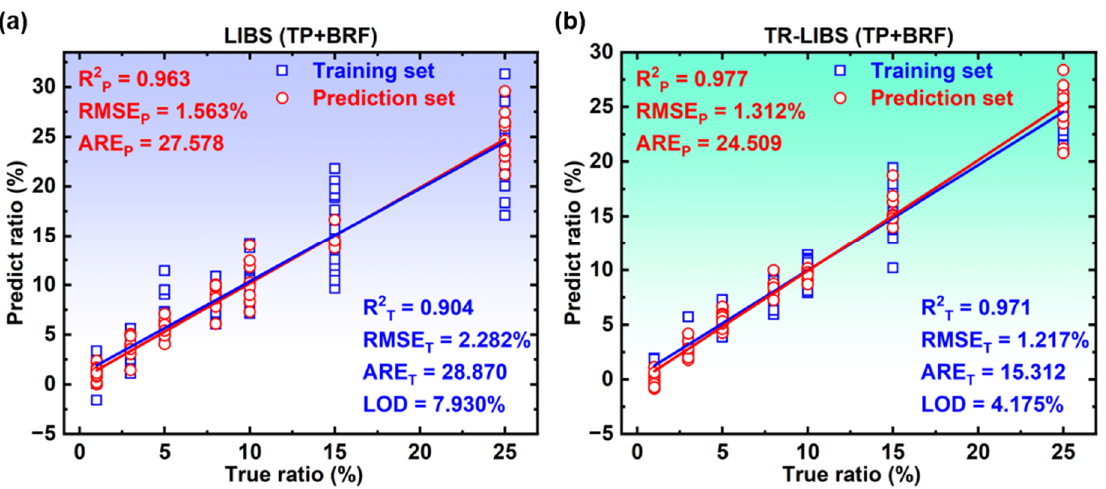
Figure 5. Linear fitting results of the PLSR model based on ( a ) LIBS and ( b ) TR-LIBS in the training set and prediction set of adulterant TP. Table 3. Comparison of quantitative analysis results of five adulterants in BRF by LIBS and TR-LIBS. The subscript value is the corresponding optimal